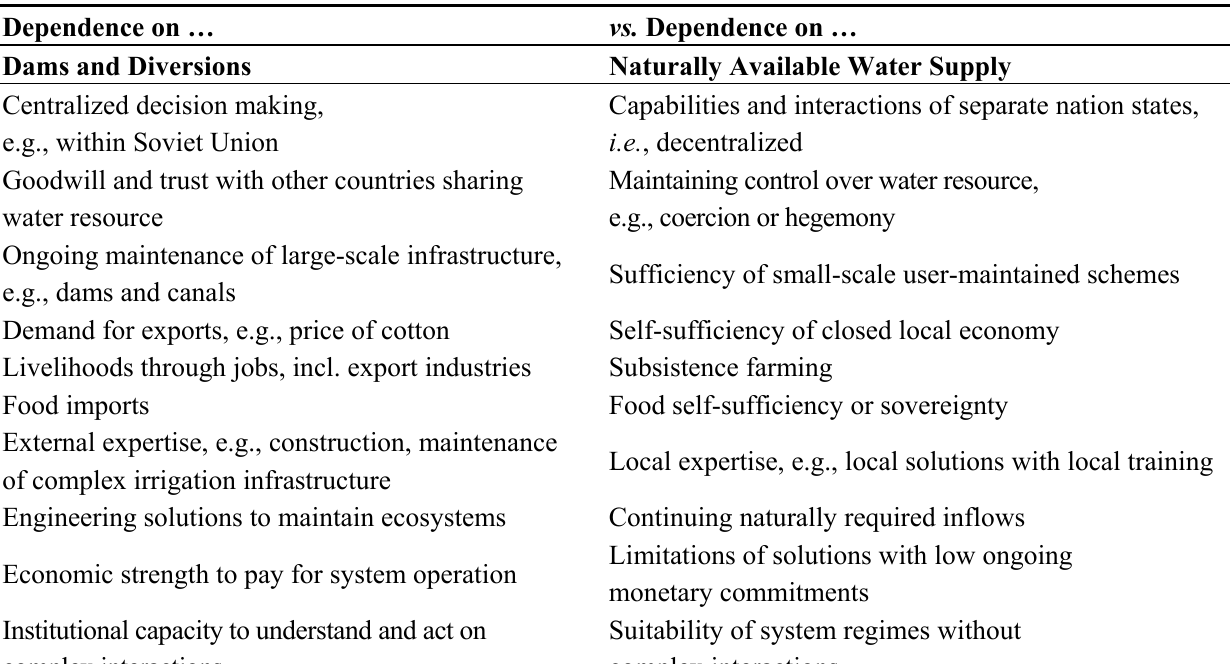
Table 2. Examples of pairs of alternative dependencies, drawn from this analysis of Central Asia. System regime may rely to varying degrees on different dependencies. Avoiding or reducing one dependency may introduce